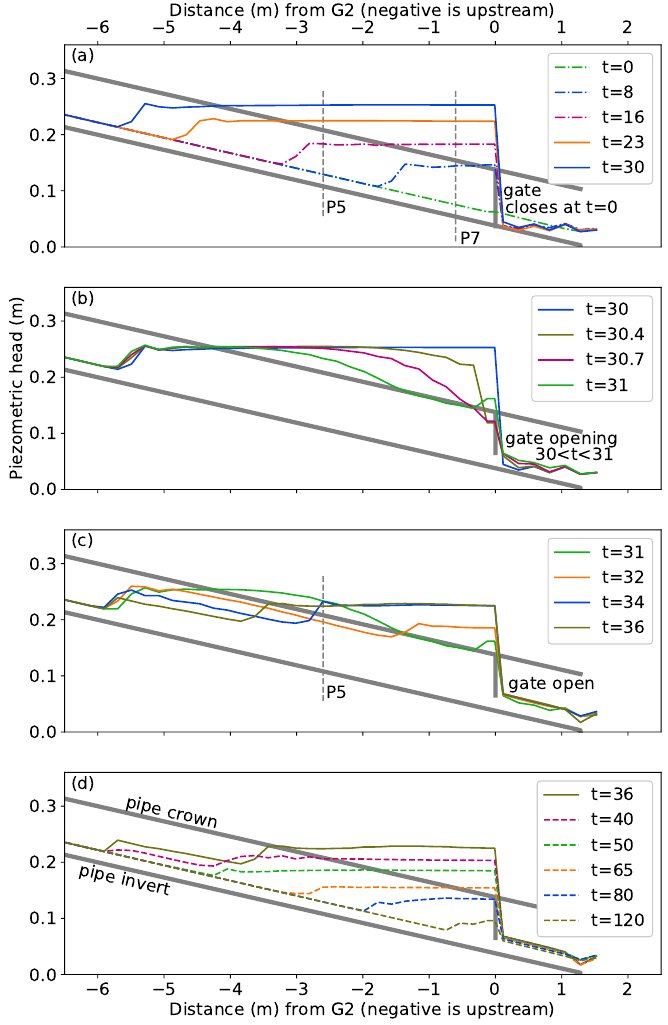
Figure 1. Profiles of piezometric head evolution for simulation of Case A3: ( a ) is progression from steady flow just before t = 0 s (with gate fully open) showing upstream propagation of upstream bore after gate closes at t = 0 s, ( b ) is initial slumping of surcharged flow as the gate is opened to 0.028 m at t = 30 s, ( c ) secondary transition phase with secondary bore, and ( d ) is drawdown to the steady condition with gate partially open. P5 and P7 are locations of pressure sensors where experimental data were